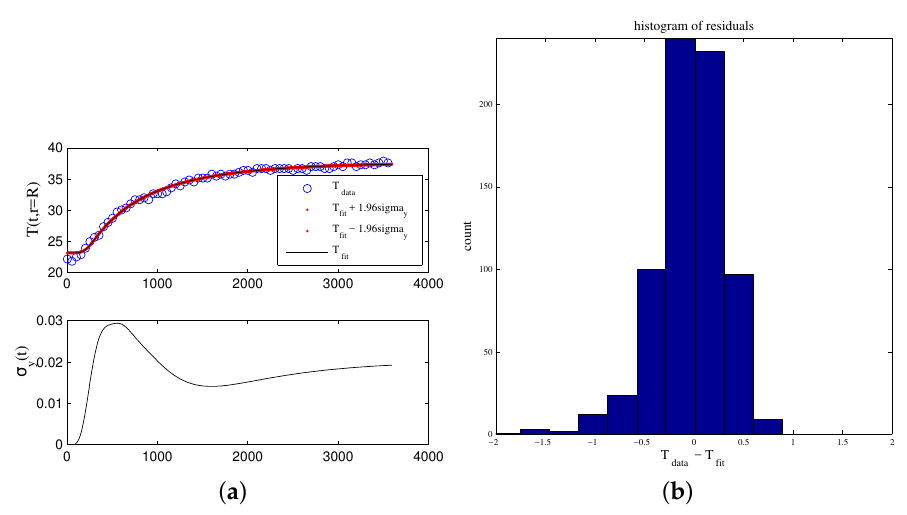
Figure 10. ( a ) top: temperature data and fitted-temperature data, with confidence intervals of 96% ( a ) bottom: standard error of the fit, σ y ( t ) ; ( b ) histogram of curve-fitting